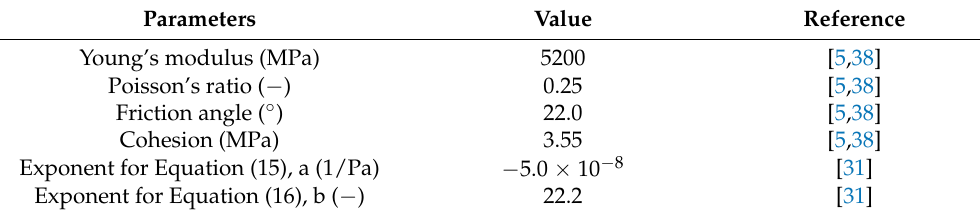
Table 2. Mechanical parameters used for the COx claystone.